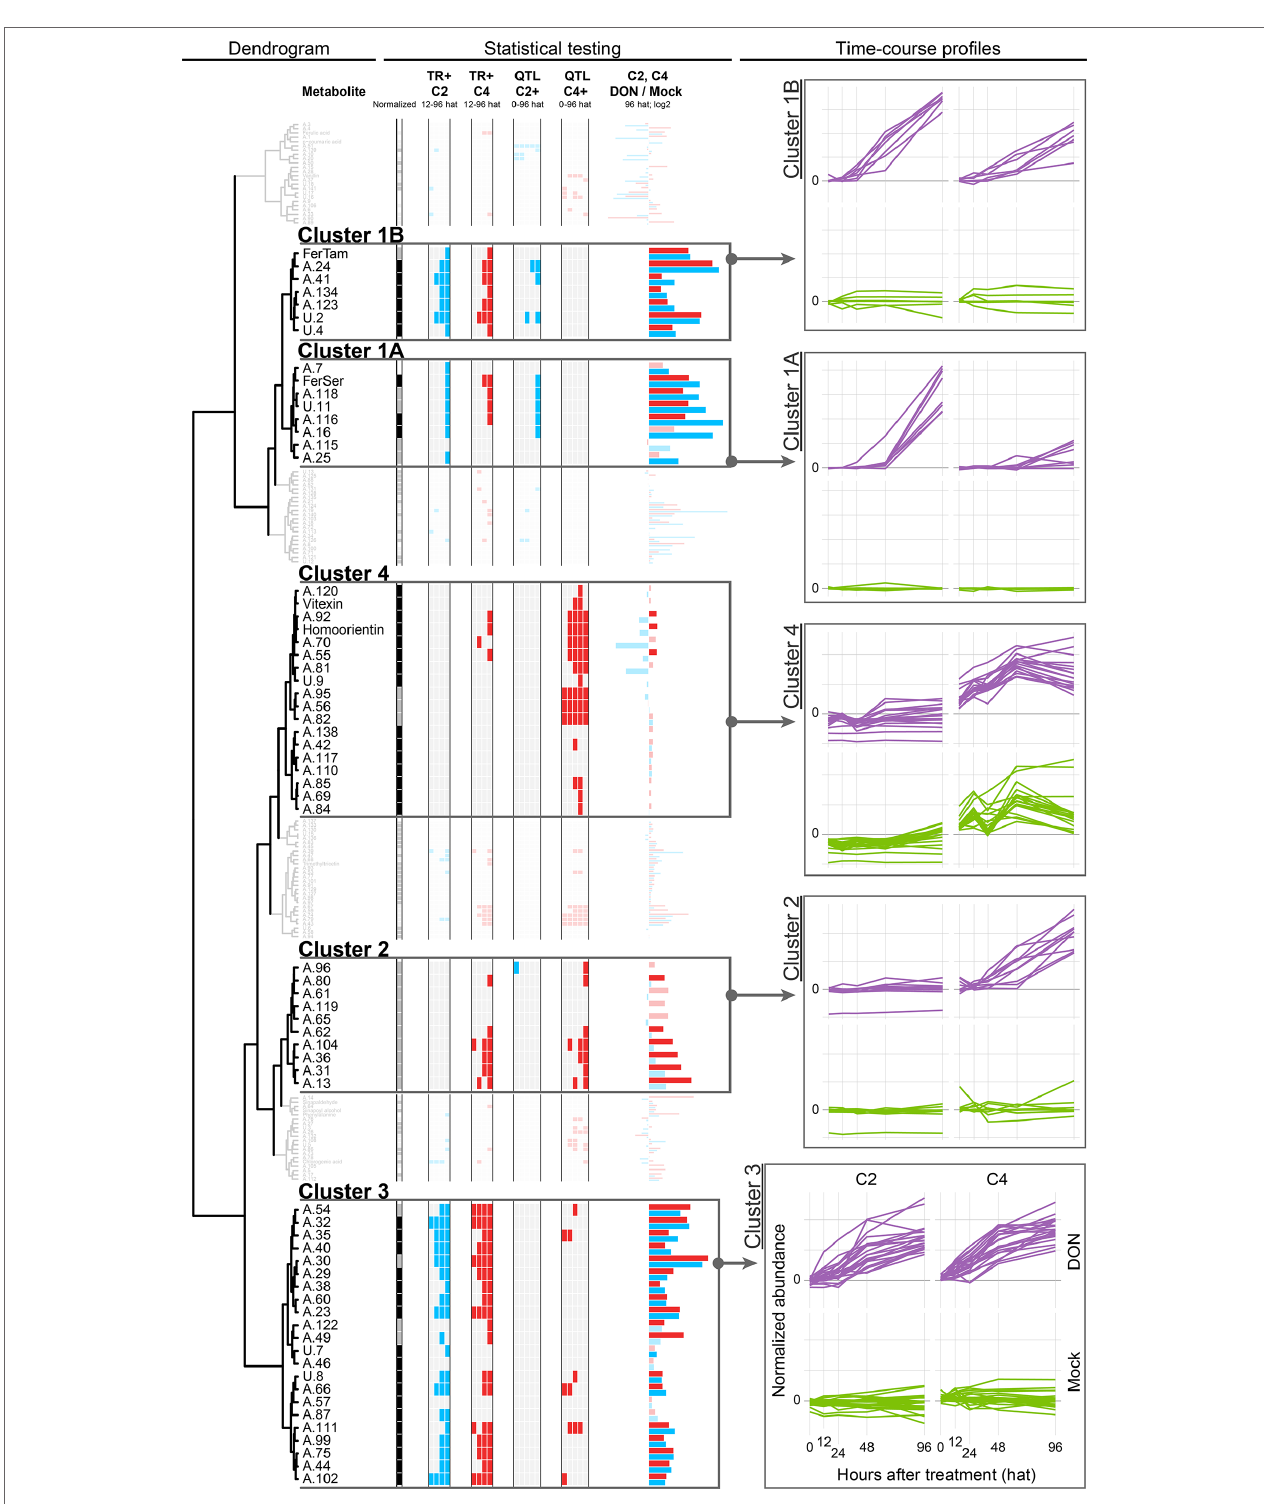
FIGURE 4 | Dendrogram of the time course profiles of the Phe-submetabolome. The results obtained from univariate statistics (TR+ and QTL effect) are depicted as color-coded columns next to each metabolite of the dendrogram. The time courses of all metabolites within a chosen cluster are depicted as overlaid graphs. Each such line in the time course represents the average abundance values obtained for the five replicates per time point and treatment (normalized to the mean value of the 0 hat mock-treated samples). Color code for normalization: black, direct normalization; gray, indirect normalization; and white, no normalization. Color code for statistical tests (TR+ and QTL effect): white, no significant difference/no effect; red/blue, significant